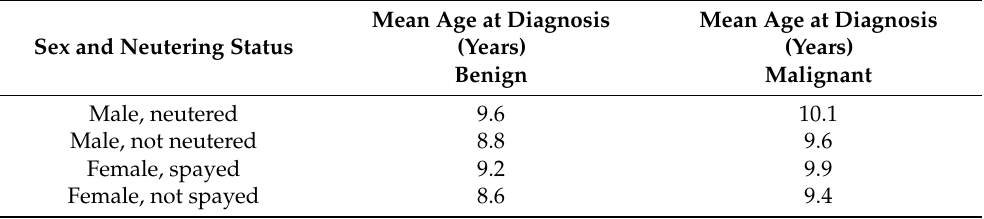
Table 1. Mean age at first diagnosis by sex, neutering status and tumour behavior.